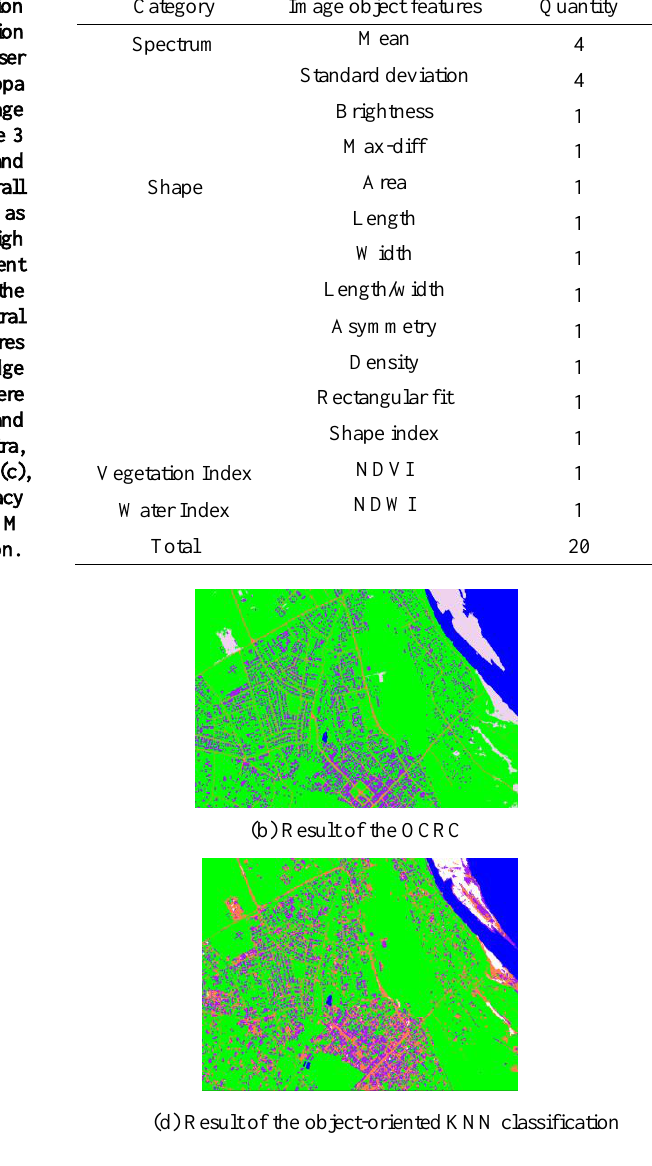
Figure 7. Classification results of three methods Table 3. Accuracy assessment of the OCRC